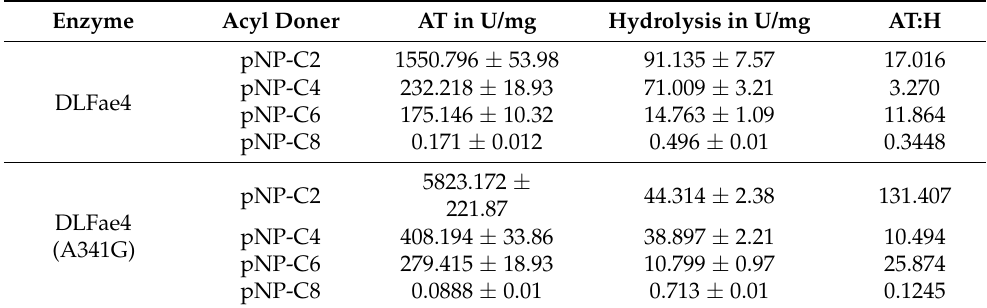
Table 2. Transfer efficiency of DLFae4 and A341G to acyl donors of different chain lengths. Enzyme Acyl Doner AT in U/mg Hydrolysis in U/mg AT:H pNP-C2 DLFae4